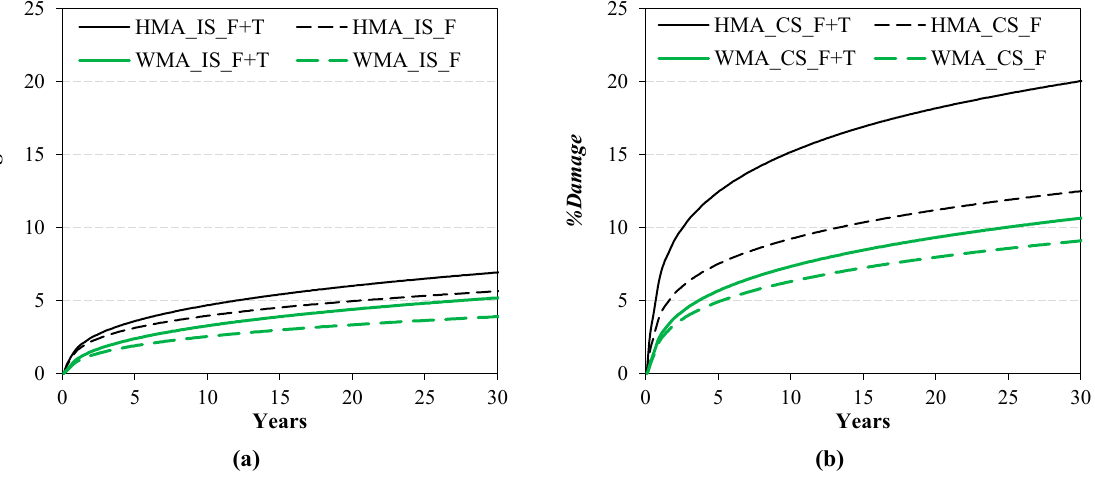
Figure 9. Damage evolution on the pavement cross-section over 30 years: ( a ) intact subbase condition, ( b ) cracked subbase condition.